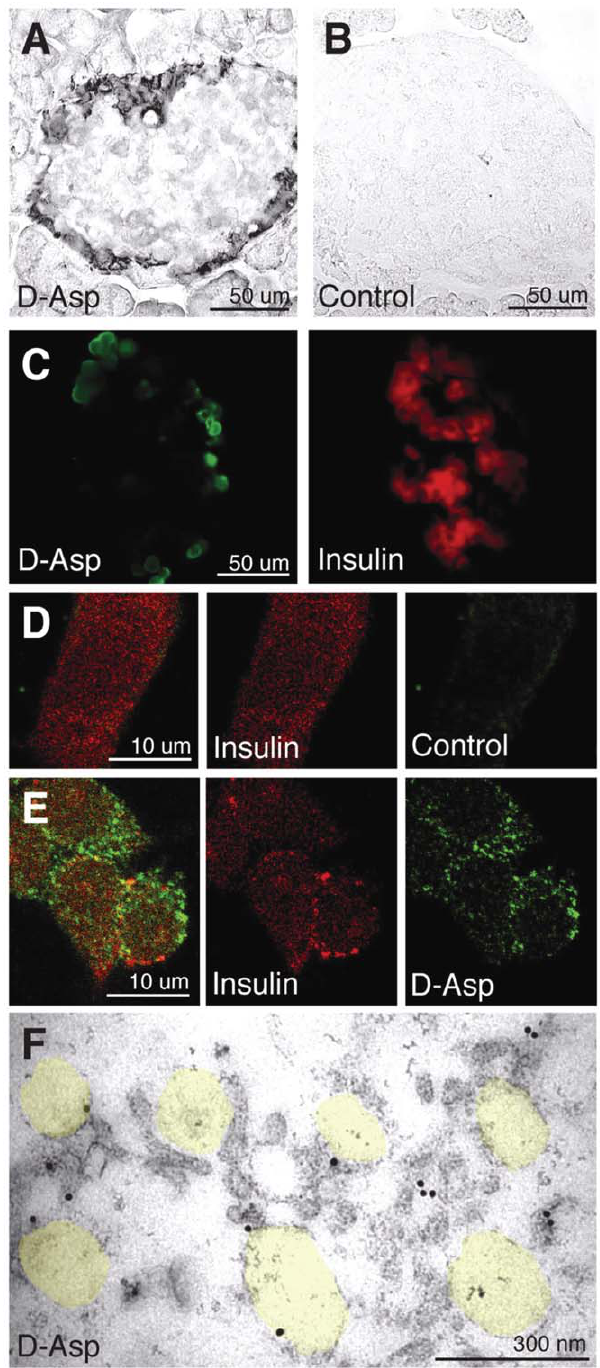
Figure 5. The glutamate analogue D-aspartate is neither taken up through the plasma membrane in intact b -cells nor into SGs in permeabilized b -cells. A–C, Acutely prepared slices of islet tissue were incubated with exogenous D-aspartate (100 m M) before aldehyde fixation and labelling with antibodies that selectively recognize D- aspartate. (A–B) Immunoperoxidase labelling shows that the tissue not exposed to D-aspartate (Control) is unlabelled, while in islets exposed to D-aspartate (D-Asp) labelling is observed only in the peripheral a -cell area, not in the central b -cell area of the islet. (C) Immunofluorescence shows that the central insulin positive b -cells are negative for exogenous D-aspartate and that the peripheral non-insulin a -cells are labelled. (D–F) Streptolysin- O permeabilized INS-1E cells were exposed to different concentrations of exogenous D-aspartate (0–3 mM)